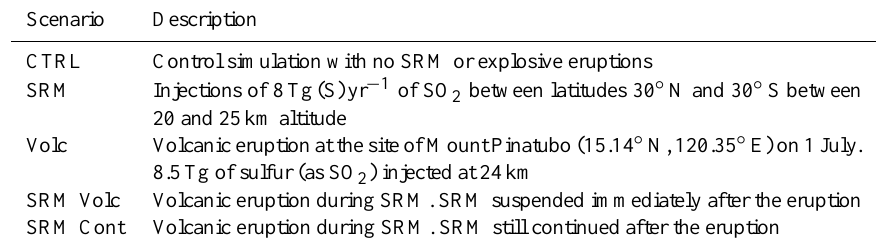
Table 1. Studied sulfur injection and volcanic eruption